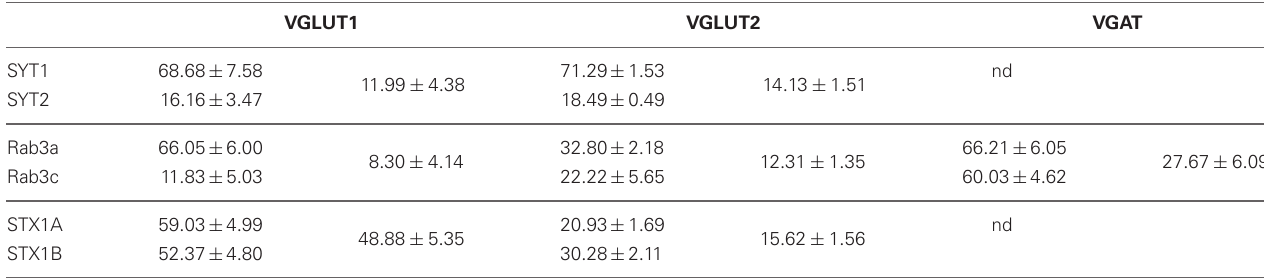
Table 1 | Quantitation of triple labeling